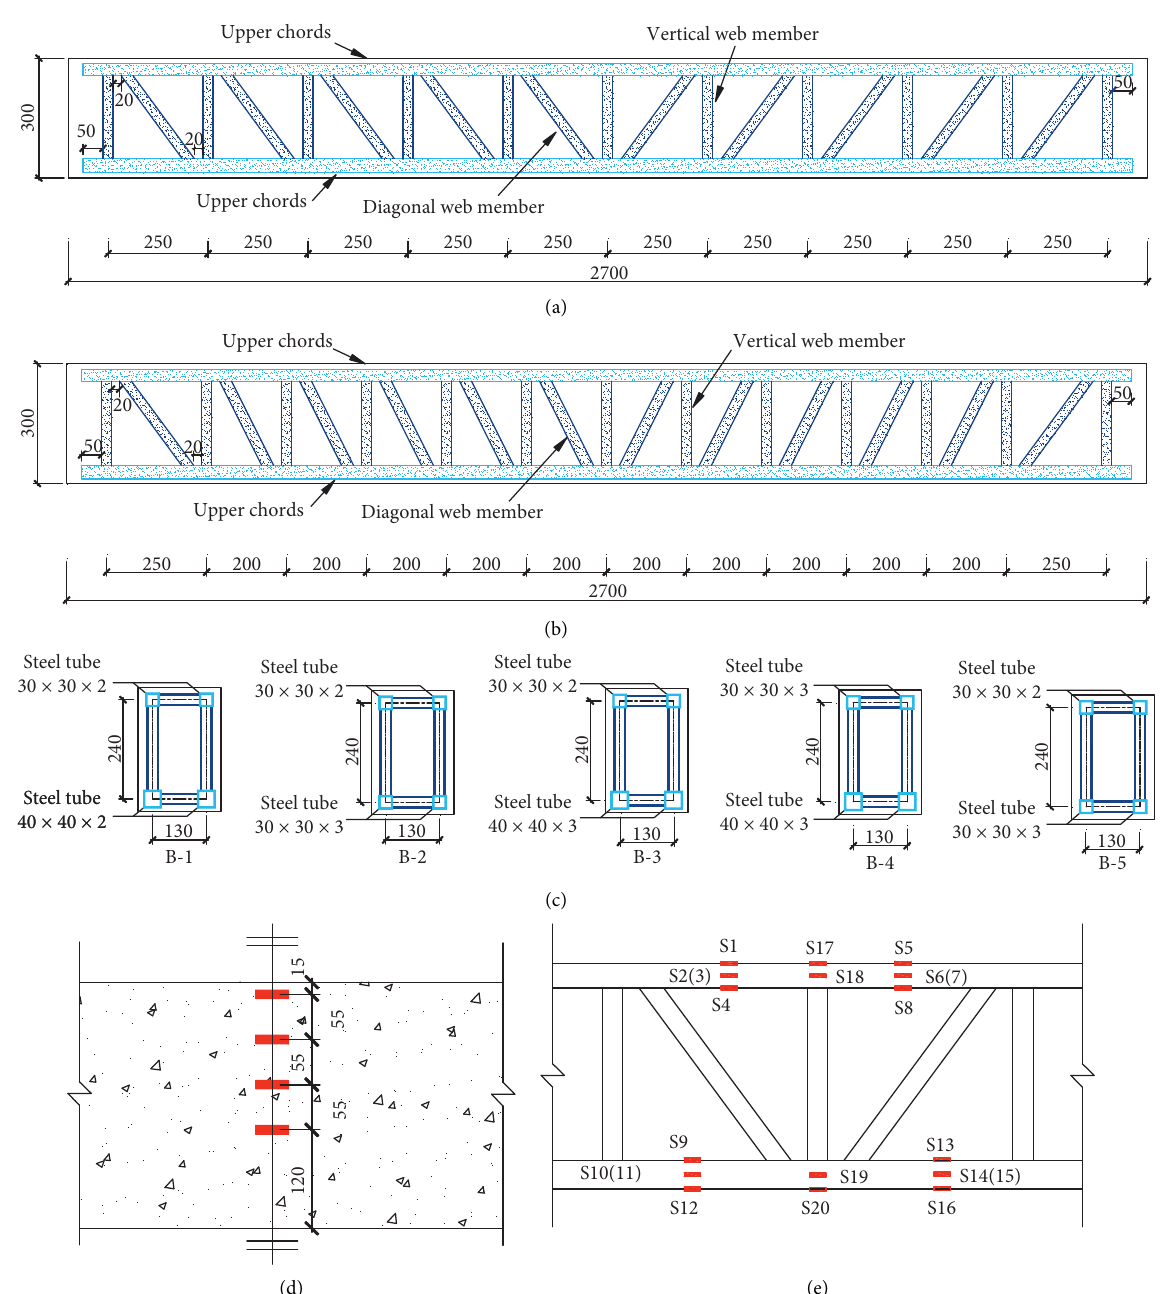
Figure 3: Detailed configurations of embedded square steel tube trusses and gauges distribution (unit: mm). (a) Elevation view for beam specimens B-1, B-2, B-3, and B-4. (b) Elevation view of beam specimen B-5. (c) Cross-section details. (d) Strain gauges on concrete. (e) Strain gauges on steel